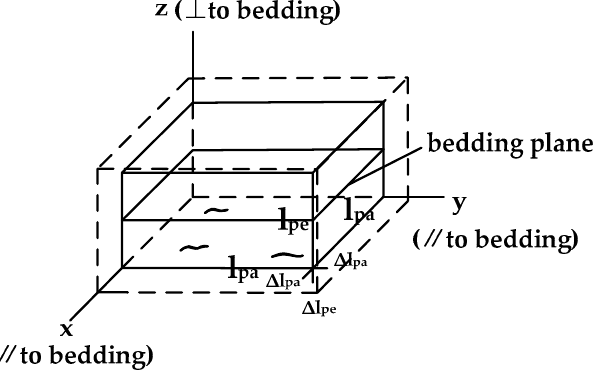
Figure 3. Sketch of original coal sample and swelling.